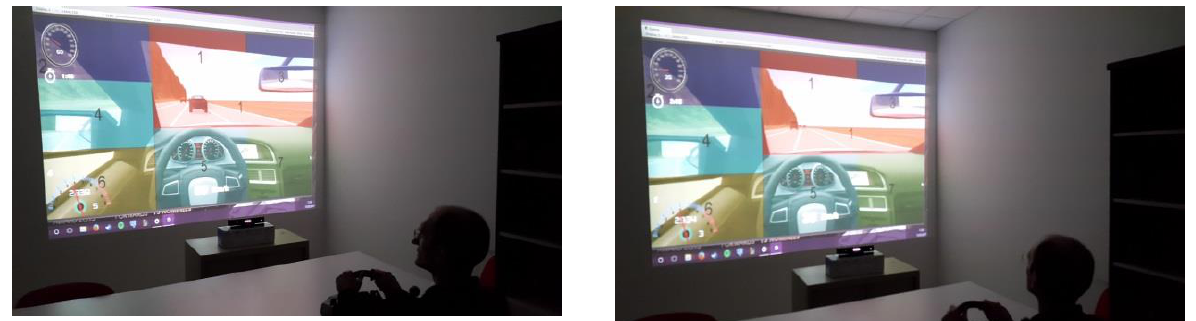
Figure 8. Simulator scenes using Kinect-based gaze region